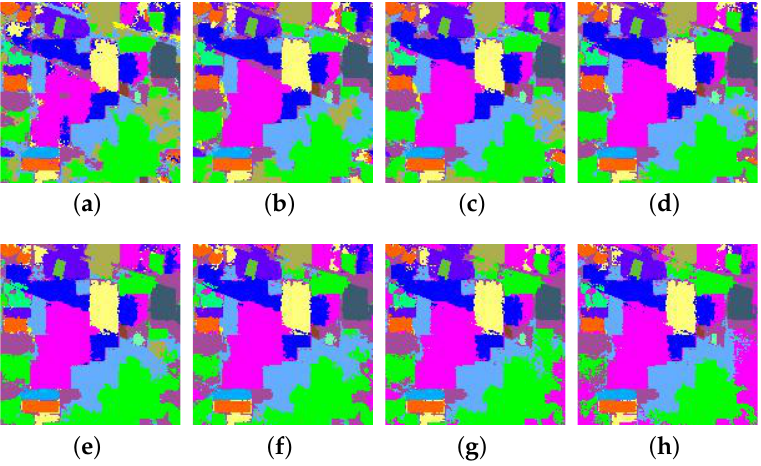
Figure 9. Full classification maps of Indian Pines data set using different numbers of scales. ( a ) one scale; ( b ) two scales; ( c ) three scales; ( d ) four scales; ( e ) five scales; ( f ) six scales; ( g ) seven scales; ( h ) eight